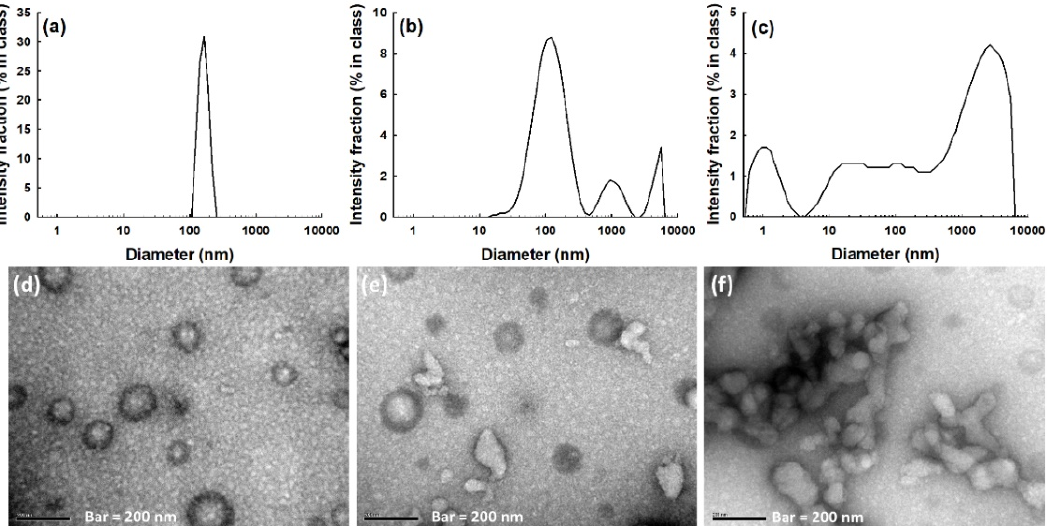
Figure 4. The effect of ROS on the changes in the particle size distribution ( a – c ) and morphology ( d – f ) of nanophotosensitizers. ( a , d ) H 2 O 2 , 0 mM; ( b , e ) H 2 O 2 , 0.5 mM; ( c , f ) H 2 O 2 , 2.0 mM. Nanophotosensitizers in PBS (pH 7.4, 0.01 M), incubated at 37 °C for 3 h in the absence or presence of H 2 O 2